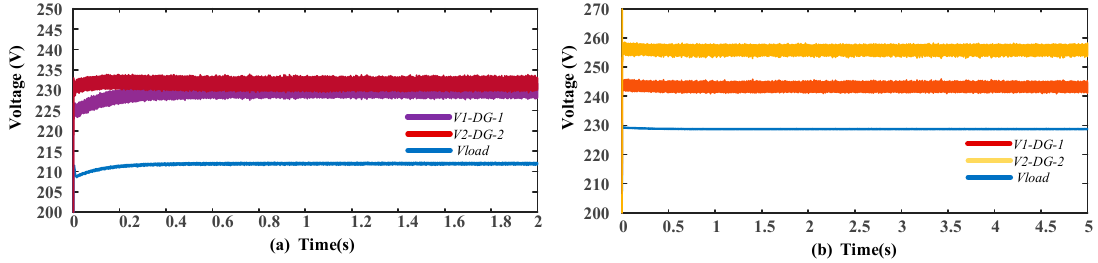
Figure 15. ( a ) Inverter terminal and load voltages for the conventional control scheme; ( b ) inverter terminal and load voltages for proposed control scheme.